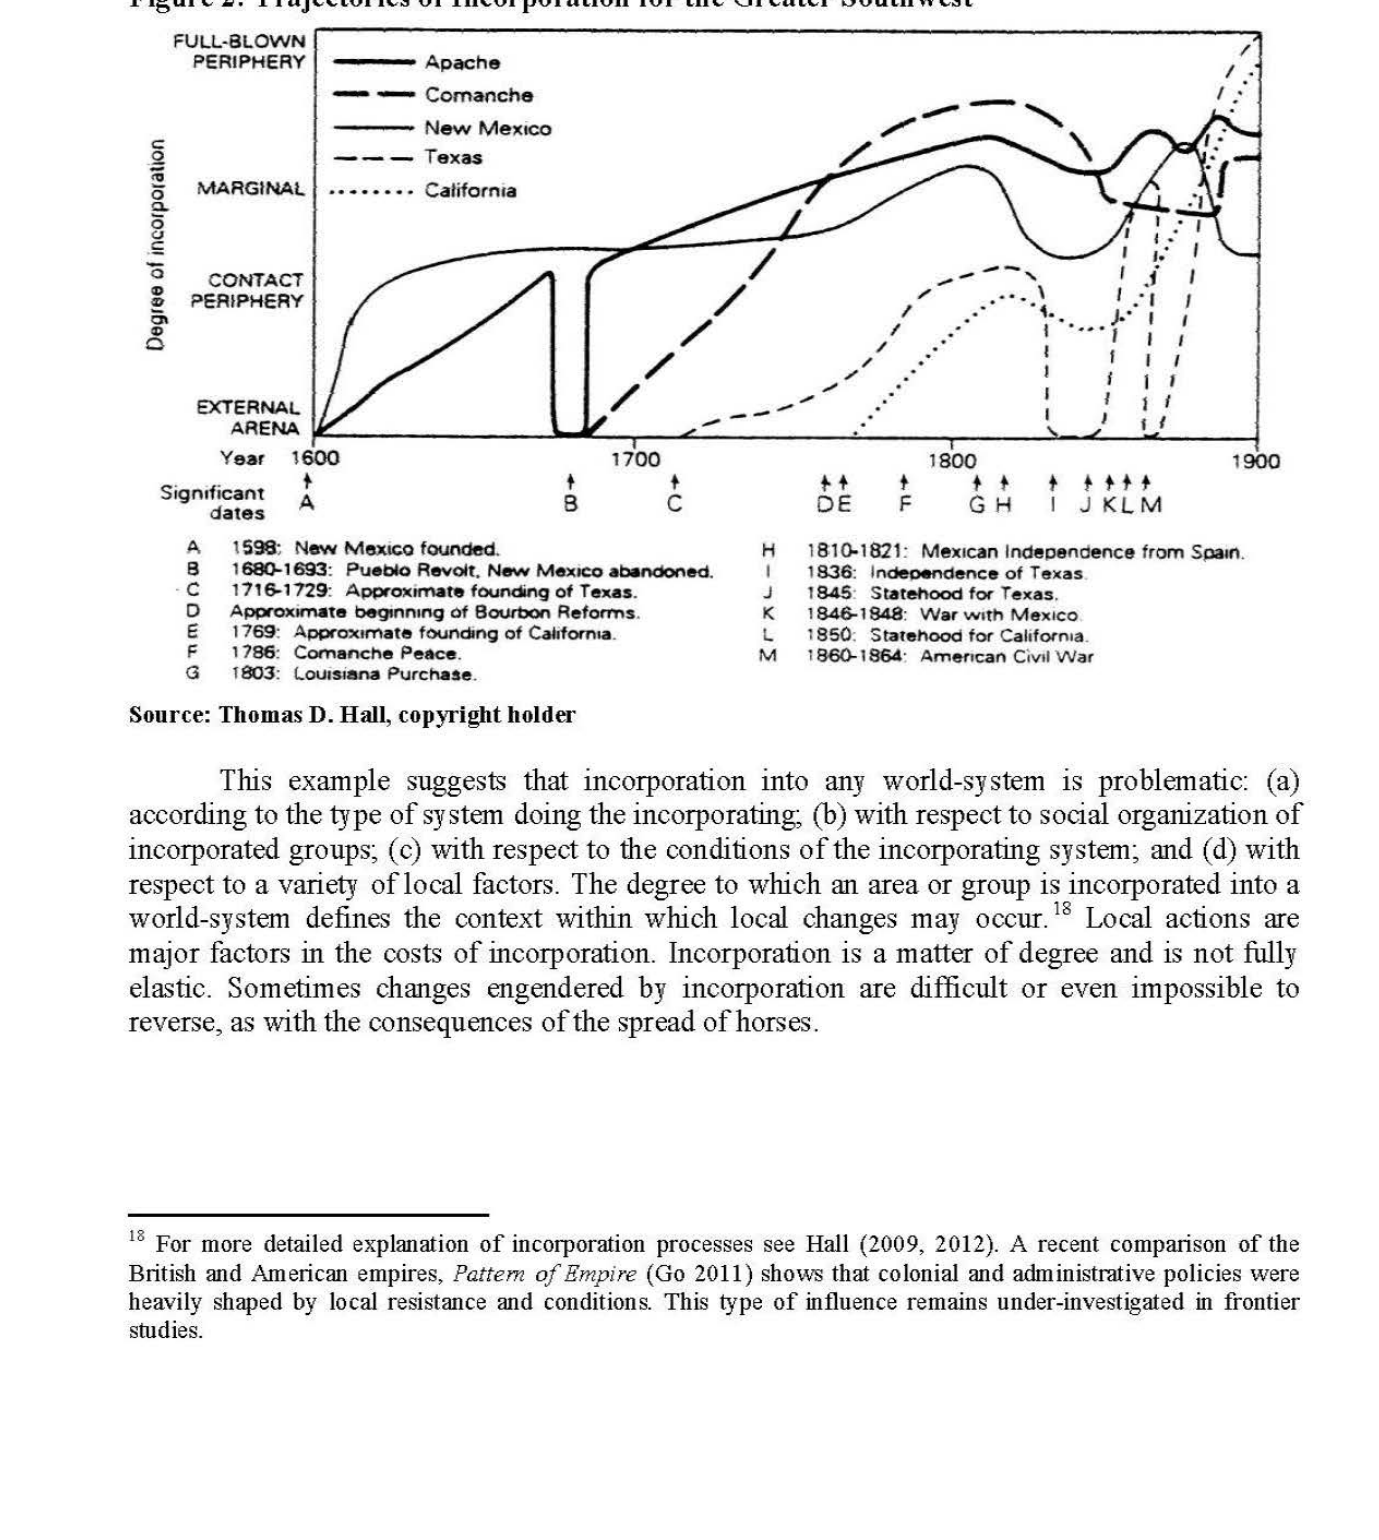
Figure 2: Trajectories of Incorporation for the Greater